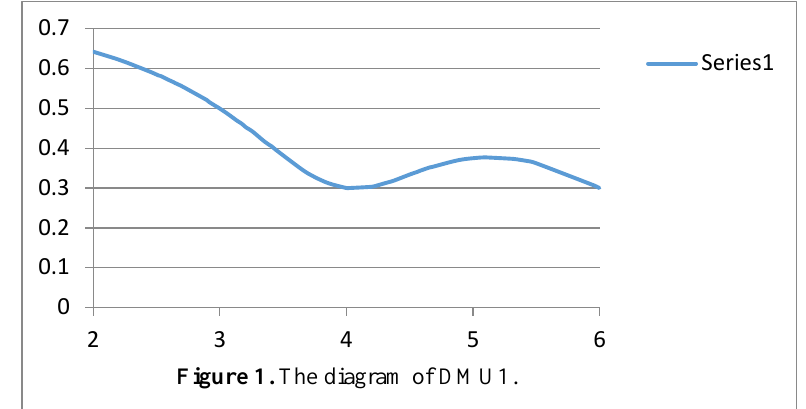
Figure 1. The diagram of